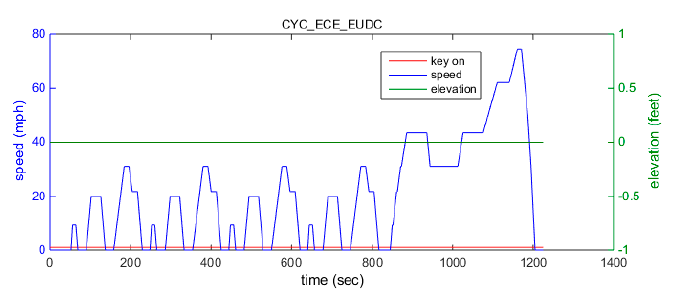
Figure 3. Economic commission Europe—Extra Urban Driving Cycle (ECE-EUDC) driving cycle.